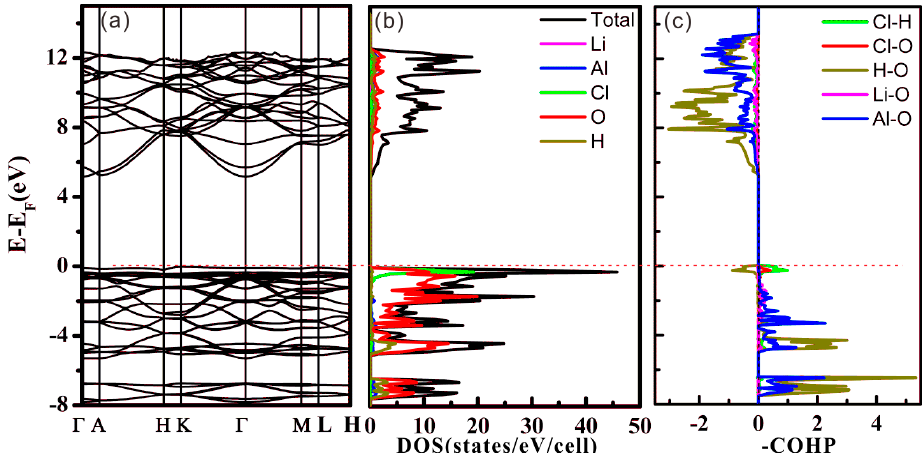
Figure 2. ( a ) Band structure, ( b ) density of states (DOSs), ( c ) crystal orbital Hamilton population (COHP) plots for LiAl 2 (OH) 6 Cl (the Li–O interactions are given in magenta, Al–O interactions in blue, H–O interactions in dark yellow, Cl–O interactions in red, Cl–H interactions in green.